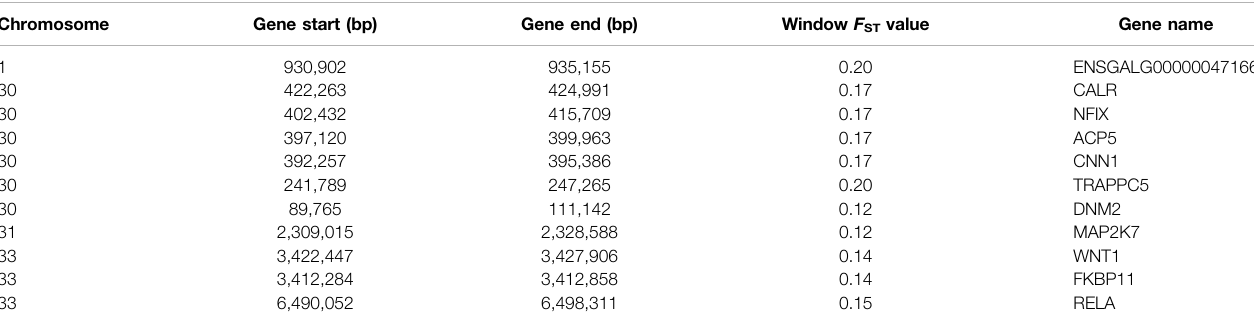
TABLE 5 | List of important candidate genes associated with keel bend. Chromosome Gene start (bp) Gene end (bp) Window F ST value Gene